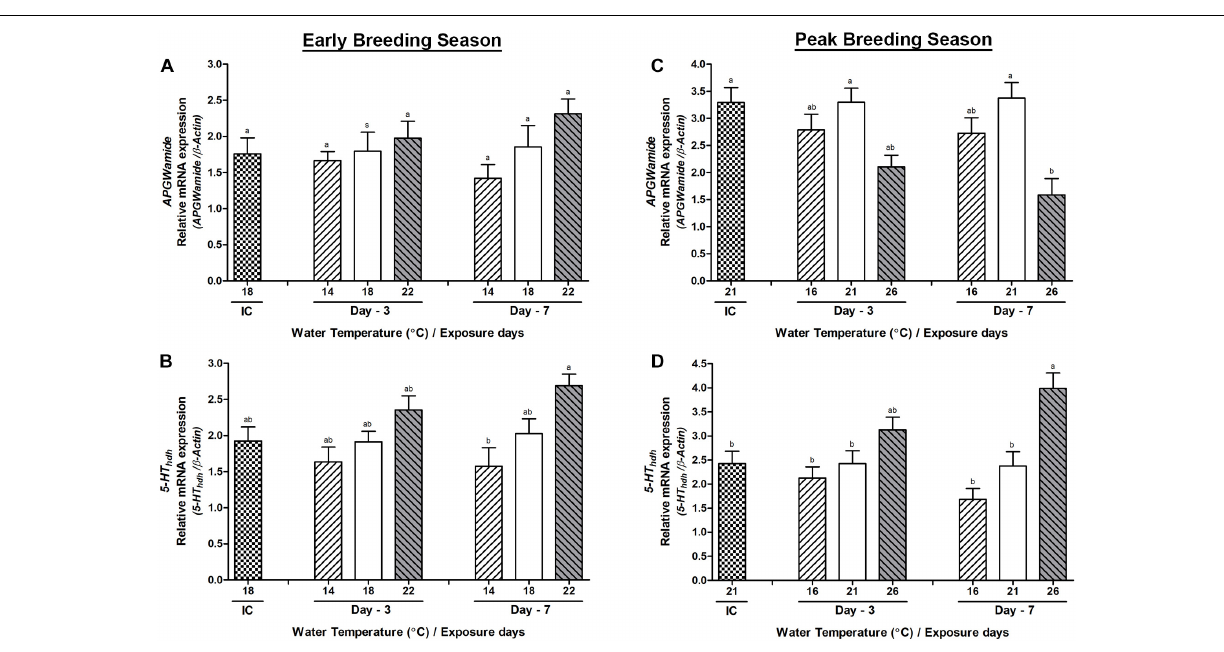
FIGURE 8 | Changes in the relative mRNA expression of Hdh-APGWamide (A,C) and 5-HT hdh (B,D) in the pleuropedal ganglion (PPG) of male Pacific abalone during early and peak breeding seasons after exposure to thermal stress for 7 days. Before exposure to the target temperature of thermal stress, abalone were sampled to obtain reference values that served as initial control (IC). Values represent the mean ± SD ( n = 10). Different letters on the bar indicate significant differences among different temperature groups ( p <